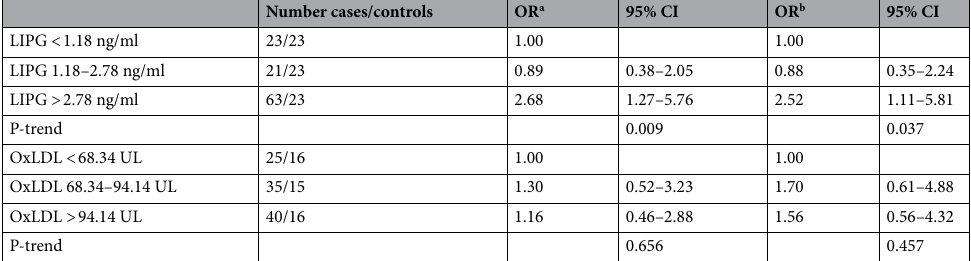
Table 2. LIPG and Oxidized LDL and breast cancer risk. a Adjusted for age at diagnosis (cases) and age at interview (controls). b Further adjusted for age at menarche, parity, menopausal status, BMI, and family history of breast/ovarian cancer.